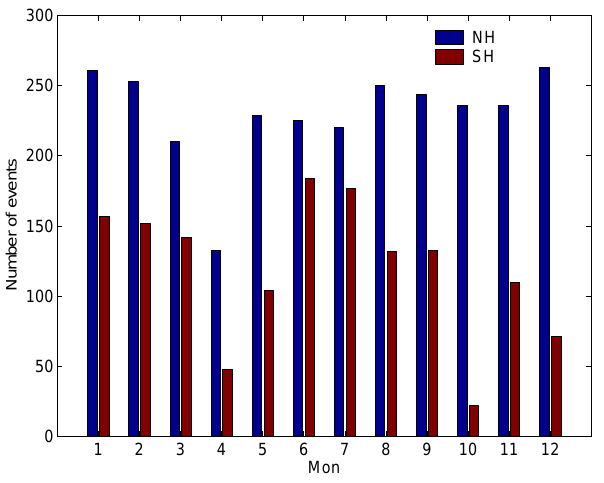
Fig. 1. Occurrence distribution of detected substorm onsets for the different months of the year, separately for the two hemispheres.